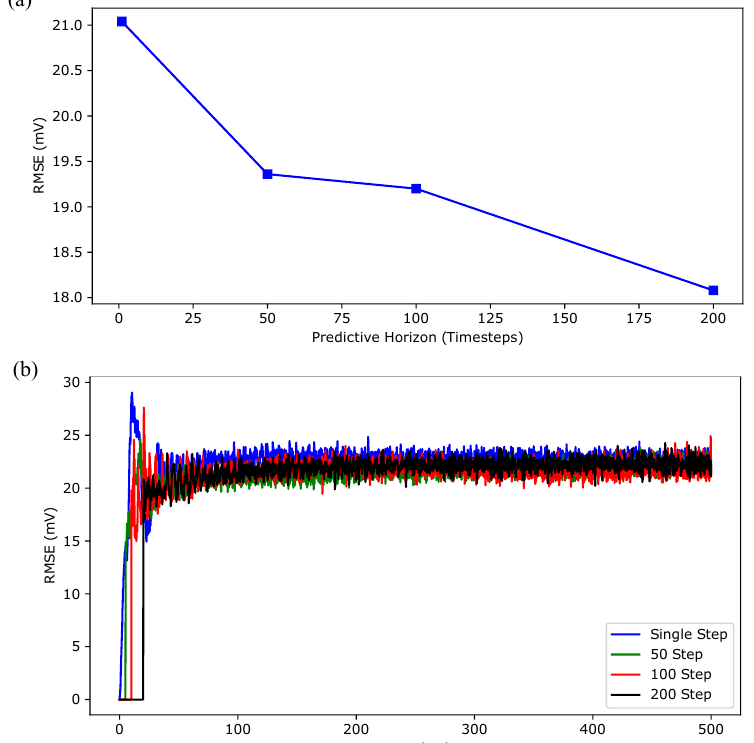
Figure 8. The effect of the length of predictive horizon of the deep LSTM neural network on the accuracy of regular spiking patterns prediction. ( a ) shows the time-averaged root mean squared error (RMSE) versus predictive horizon of the LSTM network ( N p = 1,50,100,200) for the simulation results shown in Figure 7; ( b ) shows the RMSE versus simulation time for 5000 independent realizations, drawn from the predicted membrane potential trajectories of 50 randomly selected stimulating currents from a Uniform distribution U ( 2.3,3.0 ) and 100 random initial conditions for each stimulating